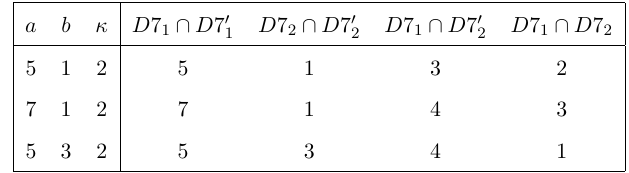
Table 11 . U(1) charges for the incomplete models with no invariant brane.